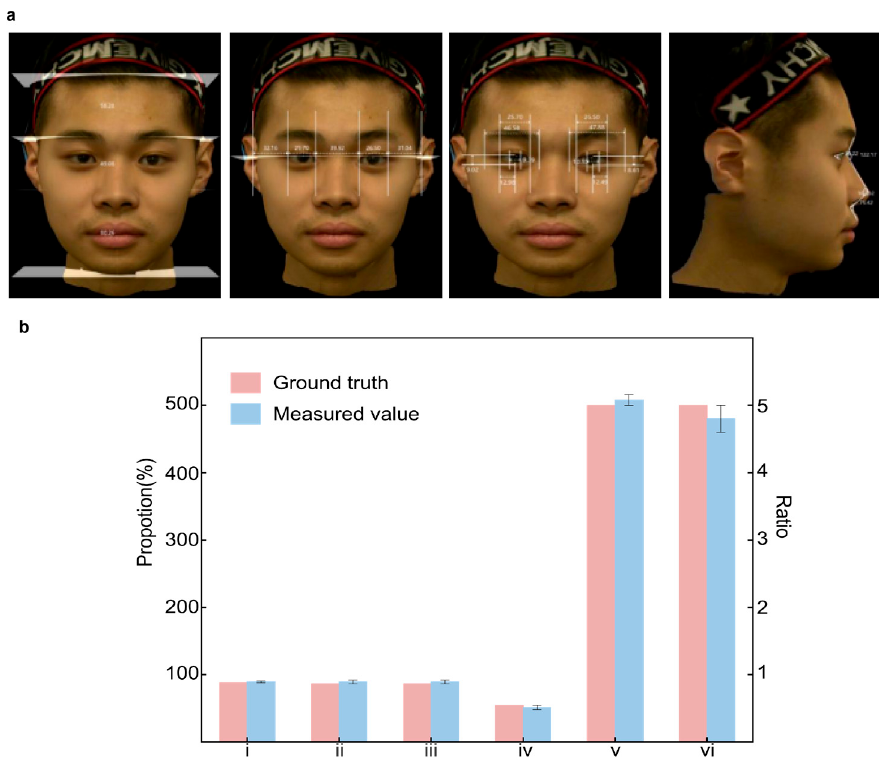
Figure 3. 3D evaluation results of key parts of face. ( a ) follow the results obtained "three courtyards", “five eyes”, eyebrows and eyes, and nose. ( b ) comparison of evaluation results.